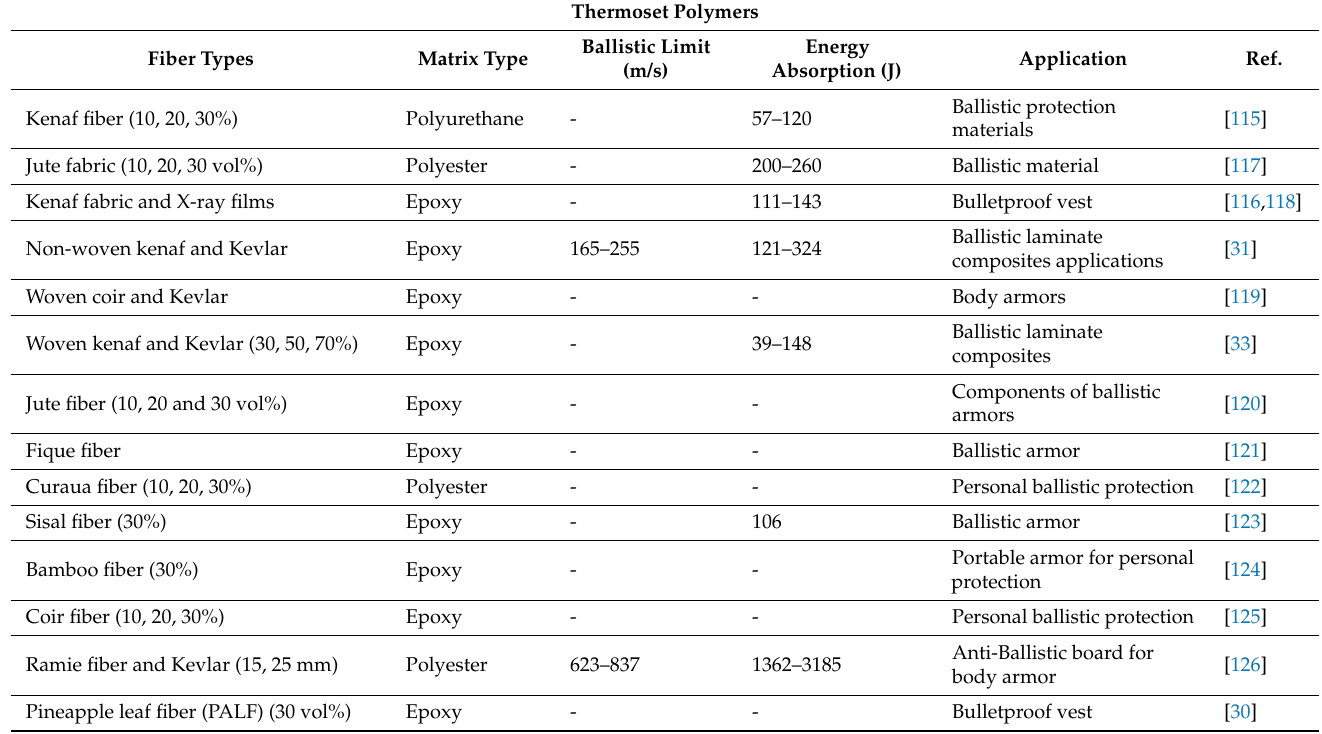
Table 14. List of reported study on utilization of natural fiber reinforced polymer composites for ballistic applications. Thermoset